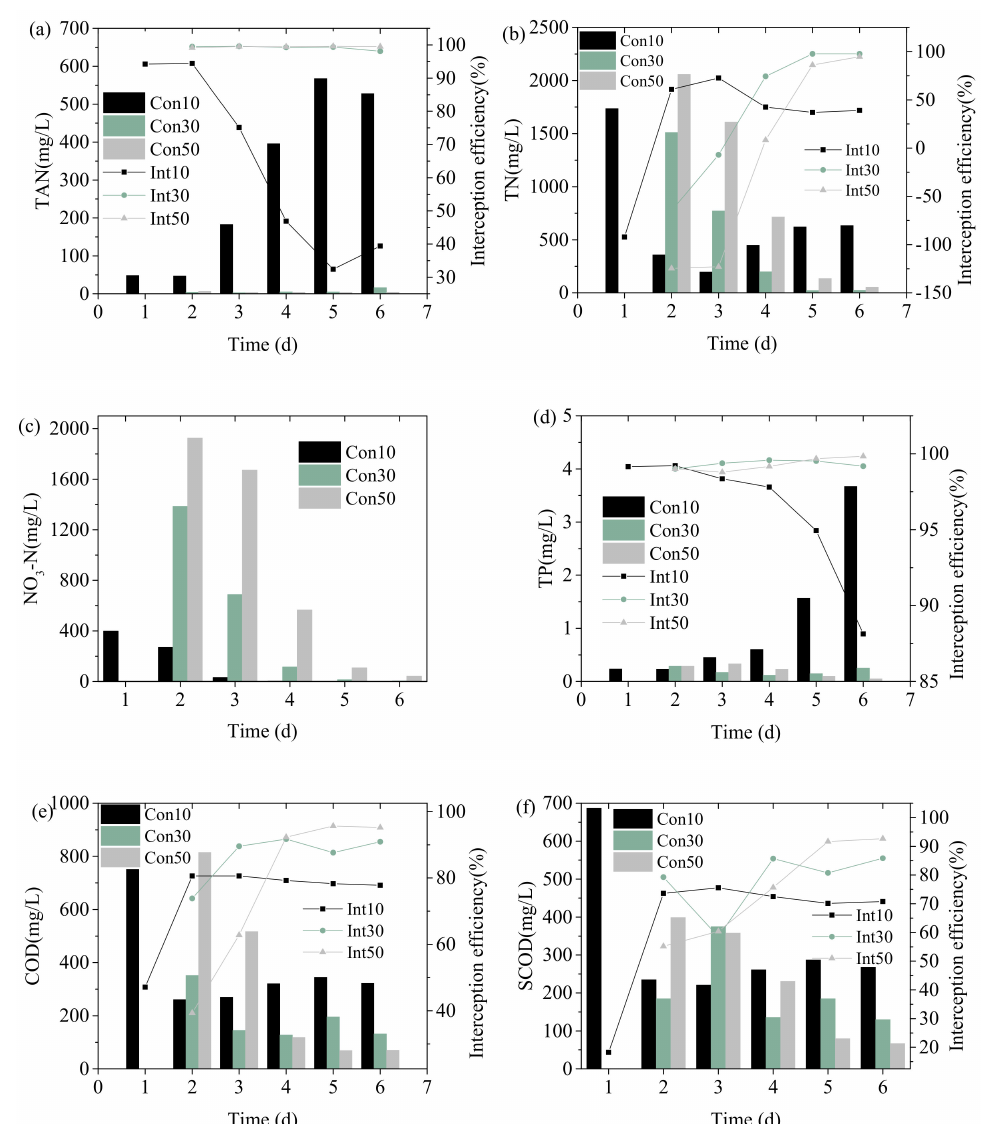
Figure 7. Concentration and interception efficiency of ( a ) TAN, ( b ) TN, ( c ) NO 3 -N, ( d ) TP, ( e ) COD and ( f ) SCOD in soil column leachate. Note: Con—Concentration; Int—Interception efficiency; 10, 30, 50 represent 10 cm, 30 cm and 50 cm; TAN—Total ammonia nitrogen; TN—Total nitrogen; NO 3 -N— Nitrate nitrogen; TP—Total phosphorous; COD—Chemical oxygen demand; SCOD- Soluble chemical oxygen